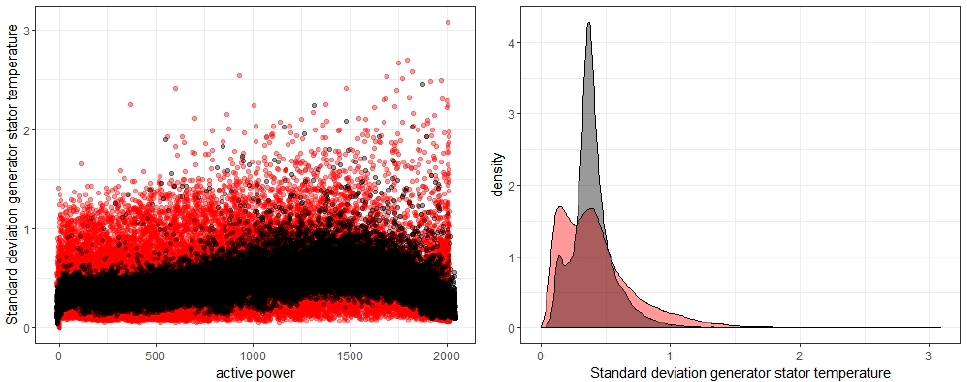
Figure 6. Relation between active power and standard deviation of the generator stator temperature (left) and the distribution of the probability density function of generator stator standard deviation (right). In red, values of turbine WT12, and in black are the mean values for the entire windfarm .